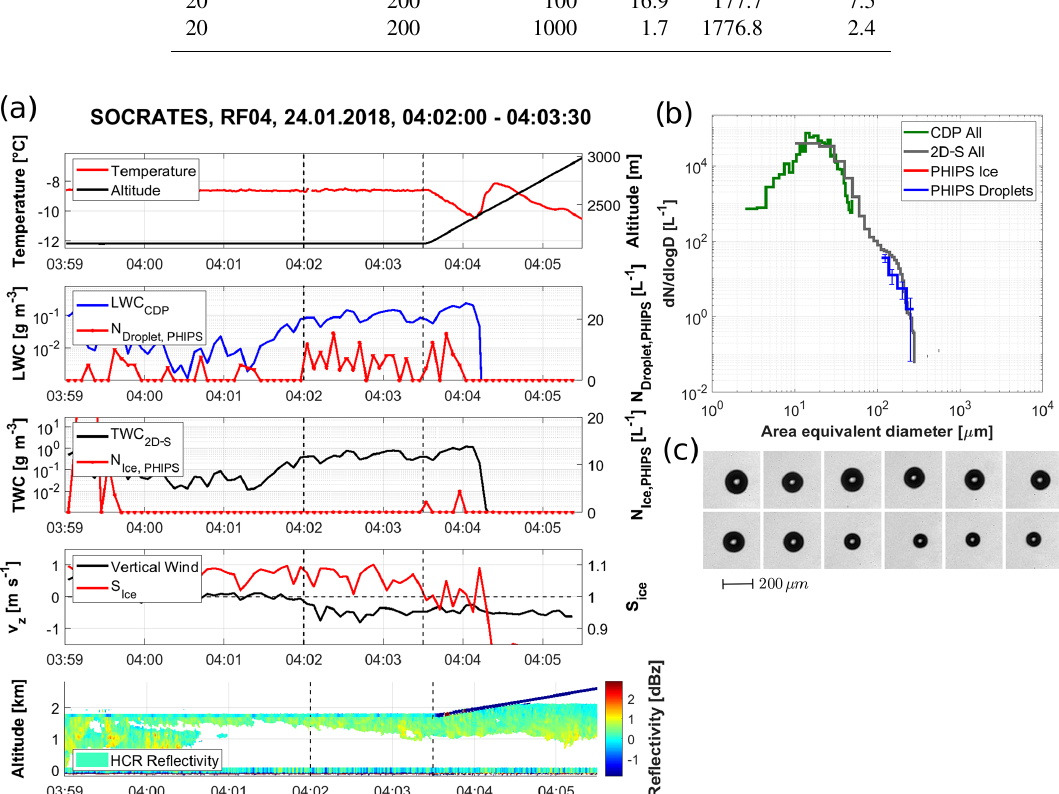
Figure 13. Example of PHIPS data acquired in a low-level supercooled liquid cloud over the Southern Ocean during the SOCRATES campaign (research flight RF04). (a) Overview of meteorological parameters, CDP, 2D-S and PHIPS number concentrations (based on the ASF data) as well as HCR radar data. (b) The comparison of the PSDs measured by CDP, 2D-S and PHIPS including statistical uncertainty √ n − 1 as discussed in Sect. 4.4. (c) Representative stereo micrographs of particles during that segment measured by bars